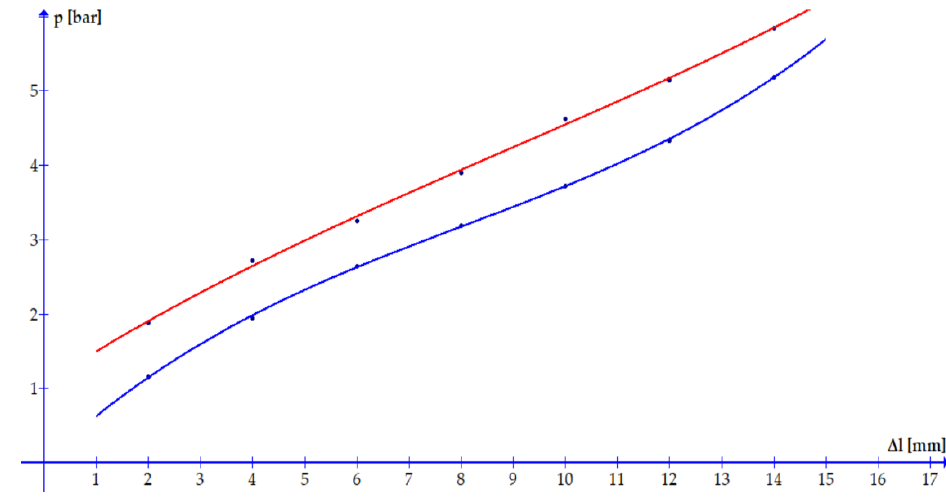
The graphs for the 2.55 kg and 4.55 kg loads are shown in Figures 12 and 13.